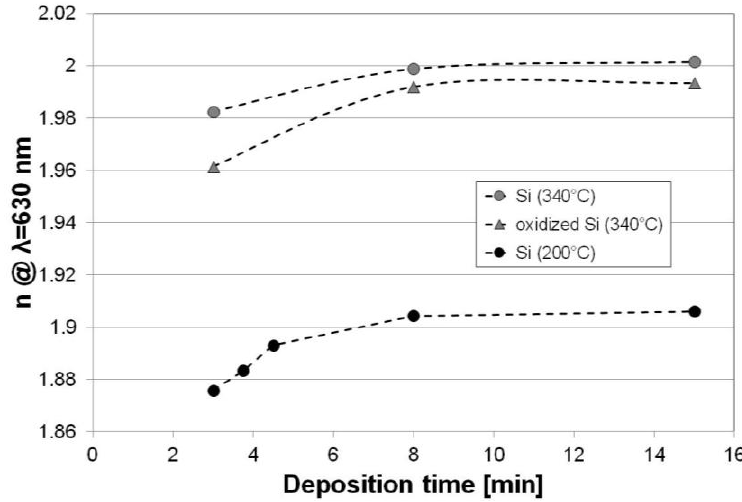
Figure 4. Evolution of the films’ n with deposition time for processes performed with T of 200 and 340 °C on Si and oxidized Si